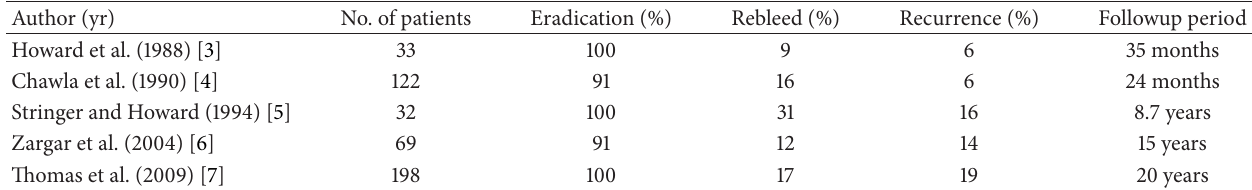
Table 1: Followup results with endoscopic variceal eradication